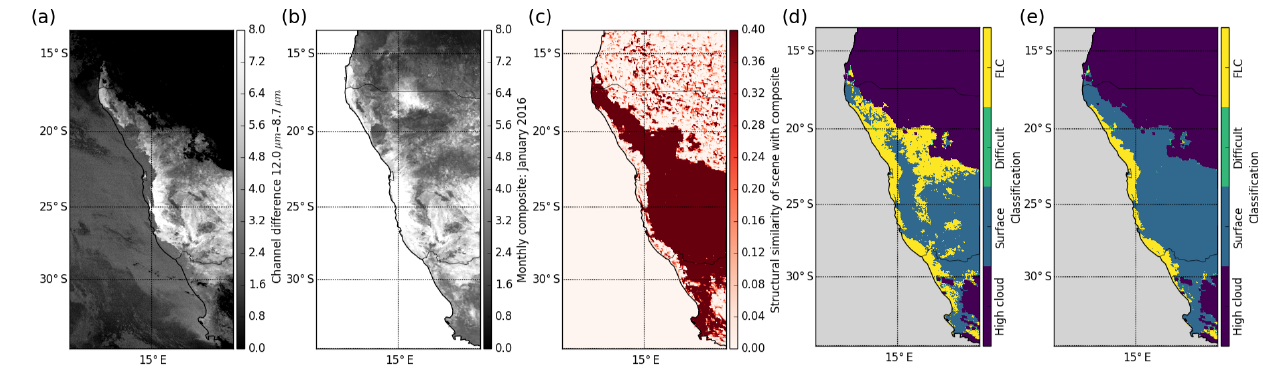
Figure 1. (a) An exemplary scene (13 January 2016, 05:00UTC) in the channel combination 12.0–8.7µm is compared to (b) the monthly composite of January 2016 resulting in (c) the structural similarity of the scene with the composite. (d) Illustration of the classification results relying on spectral tests only and (e) including the SSIM test. Quality flags are not applied in this example.